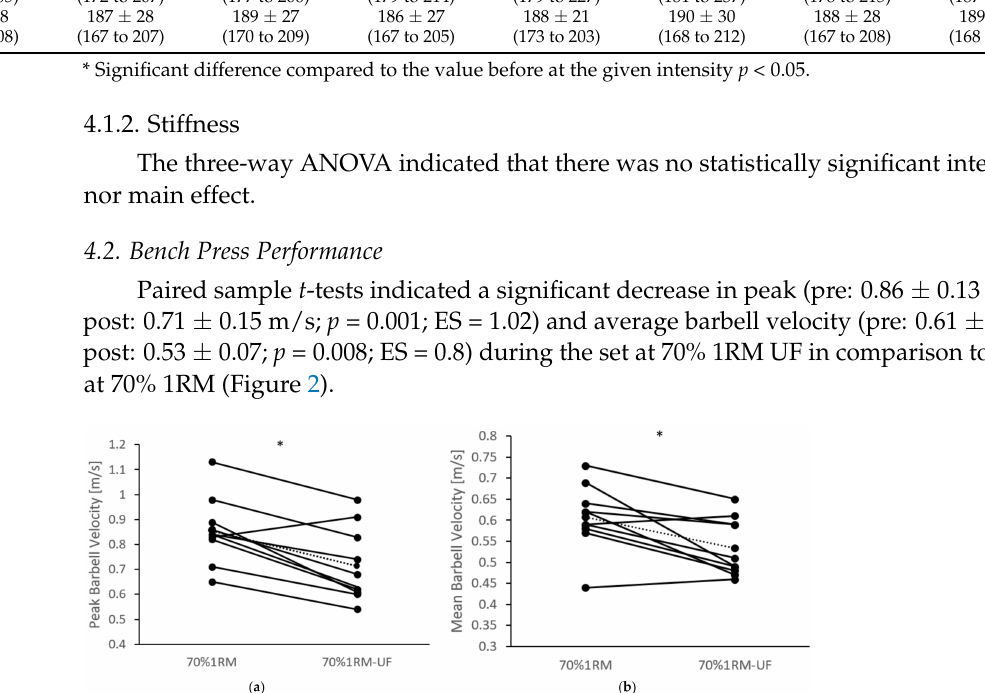
Figure 2. Inter-individual changes in the peak ( a ) and average ( b ) barbell velocity during the bench press set at 70% 1RM and the first two repetitions in the set at 70% 1RM performed until failure. * Significant difference p < 0.05. The dashed line represents the group mean